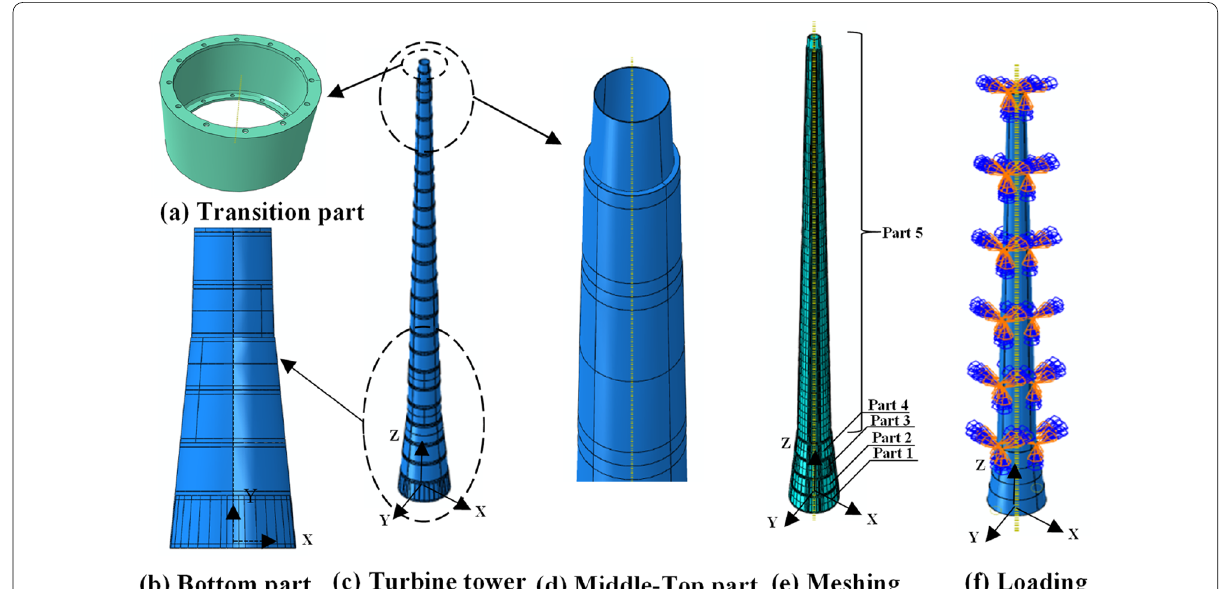
Fig. 4 Analysis model of the UHPC